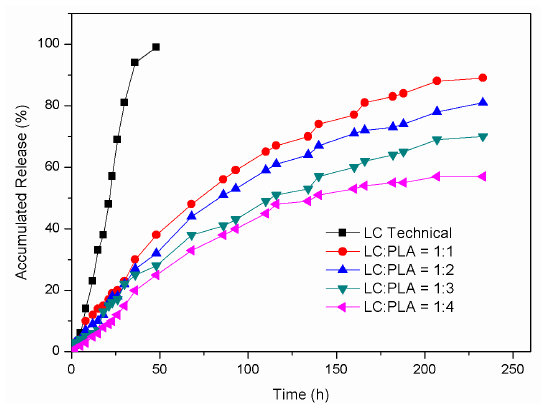
Figure 7. Release profiles of the technical LC and LC/PLA NPs with different LC loading capacities.